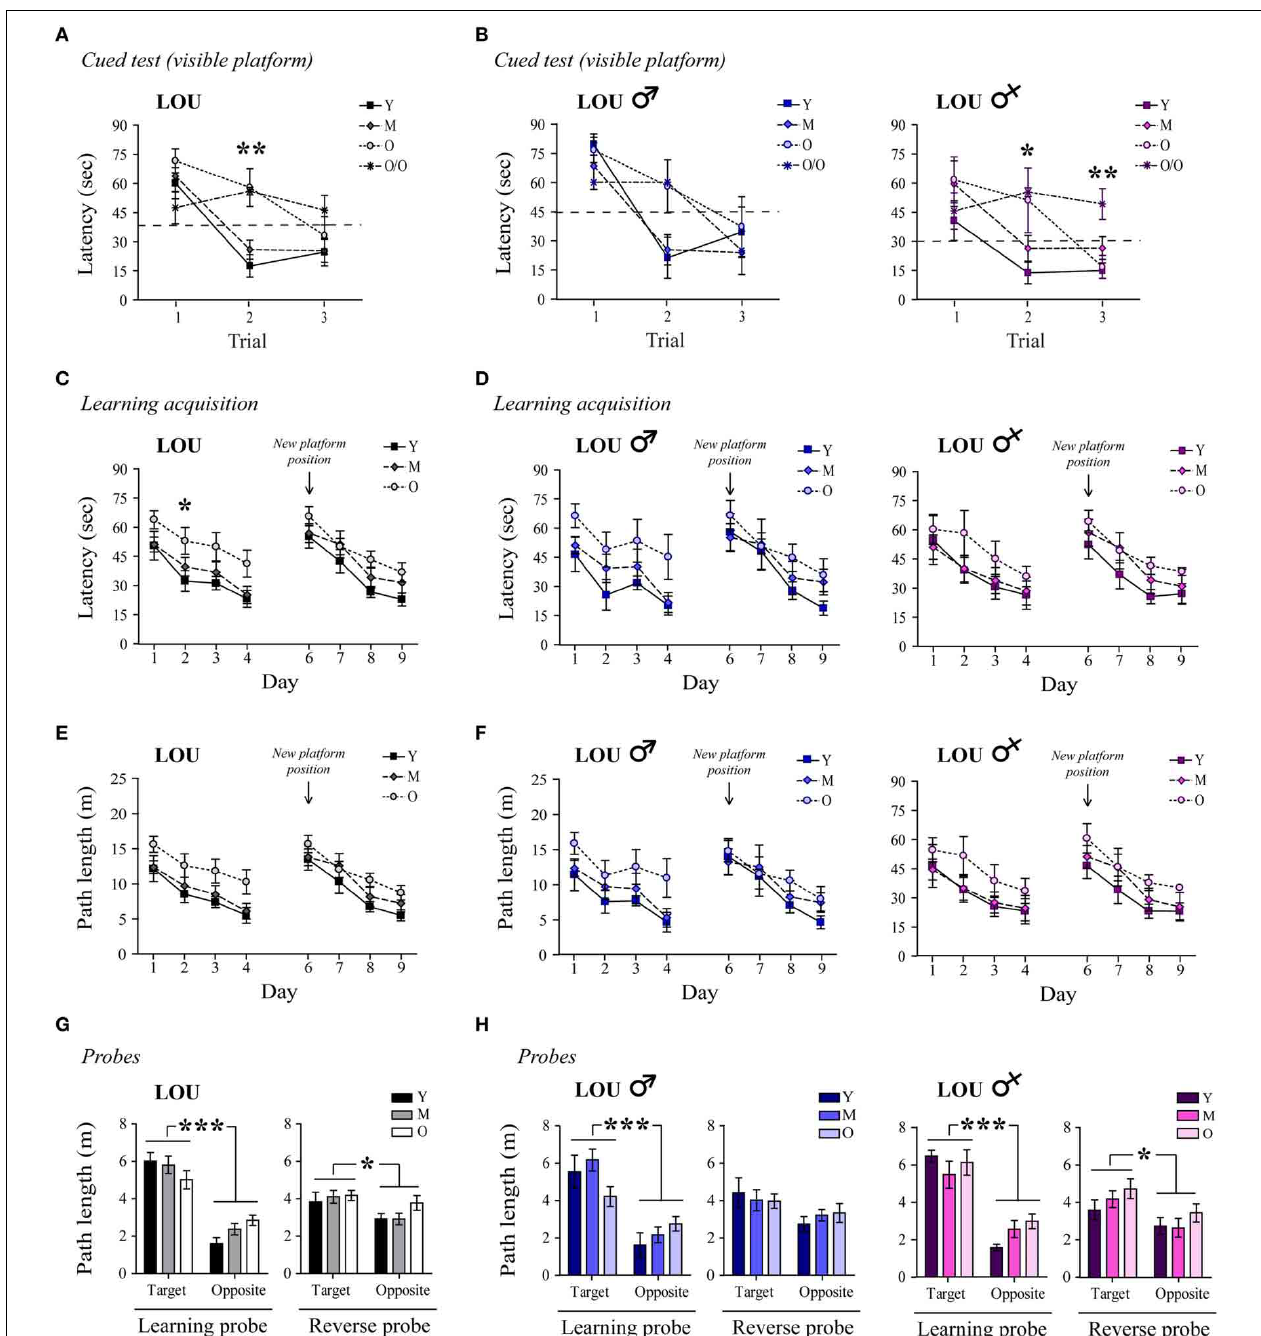
FIGURE 2 | Spatial memory acquisition is intact in old LOU rats. (A) All animals except the O/O LOU rats learned to swim to the visible platform to escape the water after three trials of 60s (delay of 30min between each trial, see Materials and Methods, for exclusion criteria). A flag was positioned on the platform as a visual cue. (B) Very old female LOU rats lacked motivation to escape water. (C) Morris Water Maze (MWM) learning acquisition curves of aging LOU rats (day 1–4, three trials per day). Old LOU rats took more time to find the platform only on day 2. After 1 day of rest, the platform was moved to the opposite quadrant to assess inhibitory learning acquisition (day 6–9, three trials per day). Performances were